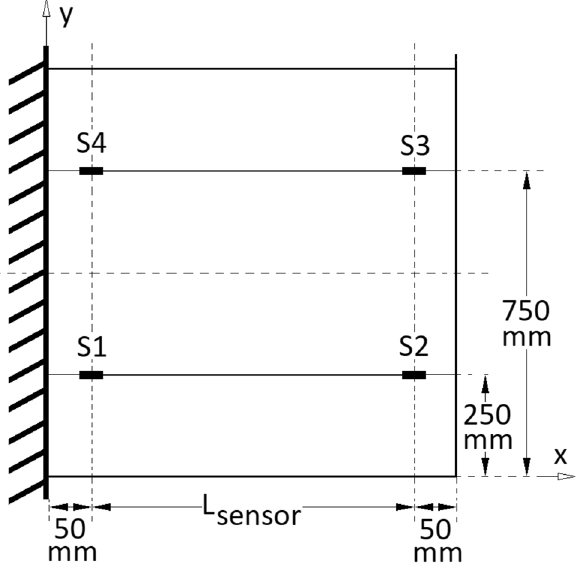
Fig. 8 Location of the sensors on the plate. S1-S2 and S3-S4 run in the clamped-free direction and are parallel to the central axis. The sensor pairs are 250 mm and 750 mm from the origin, respectively